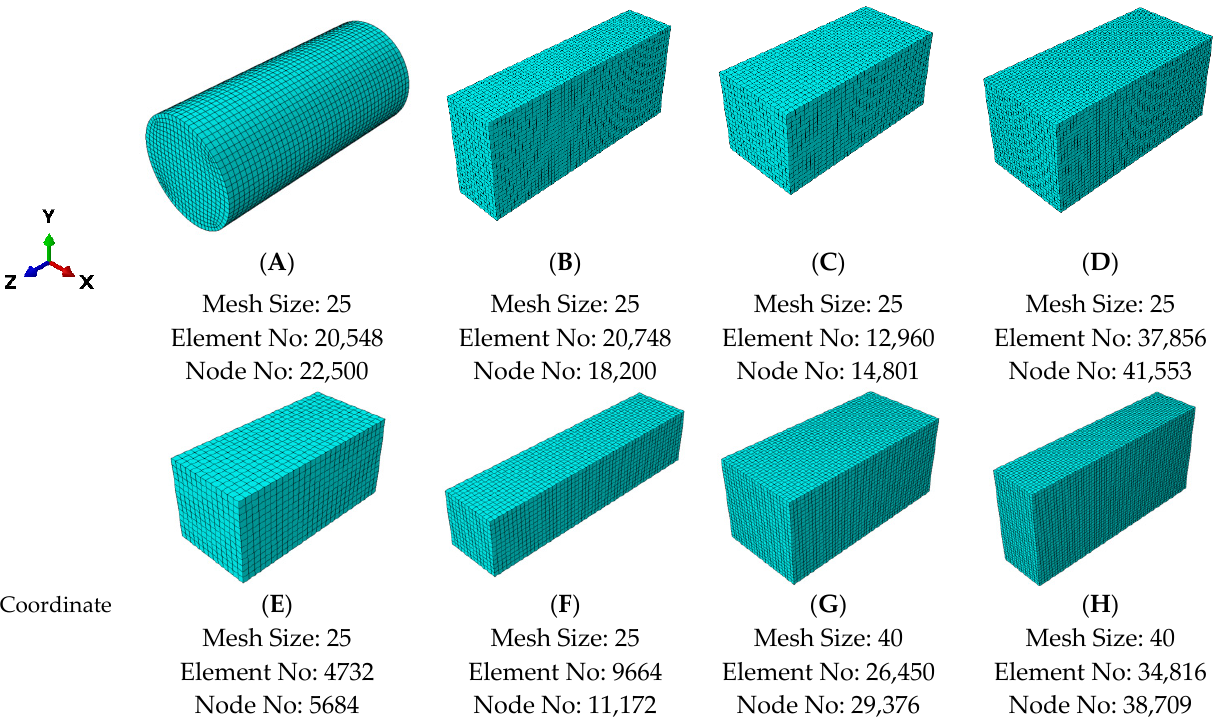
Figure 2. Discretization of